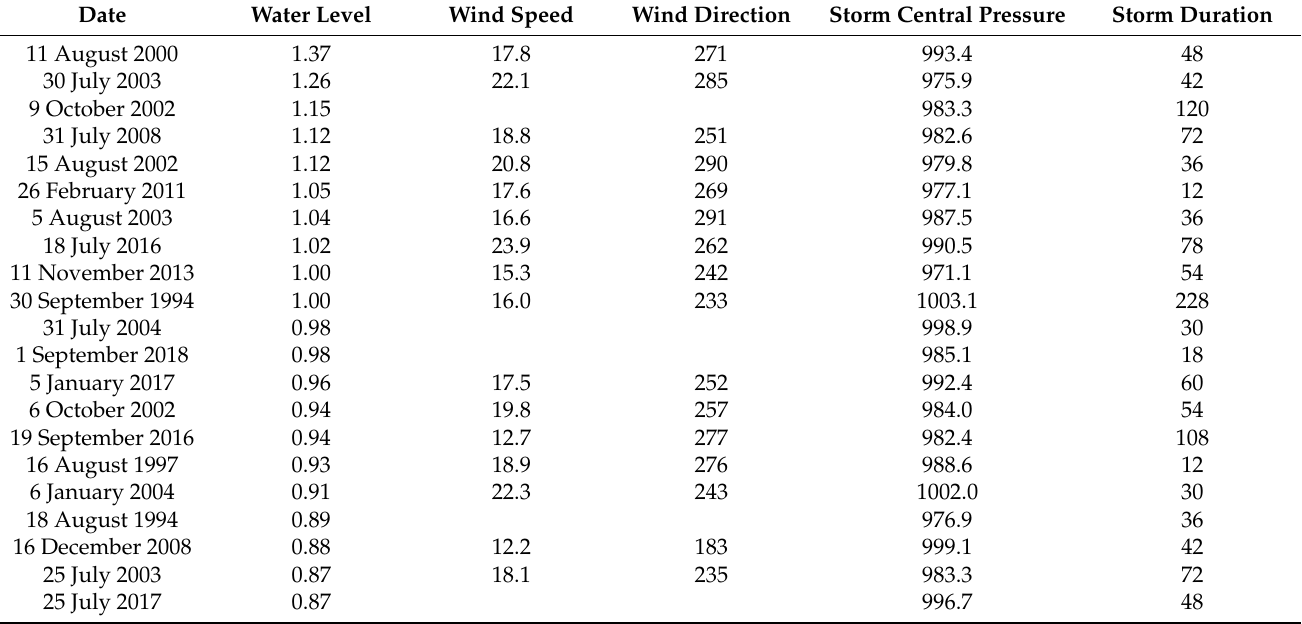
Table 1. Water level (m) extremes exceeding the daily 95th percentile with maximum daily wind speed (m/s) and mean wind direction (degrees) from the tide gauge station at Prudhoe Bay (1990– 2017). Minimum storm central pressure (hPa) and total duration of the storm (h) impacting the region identified by the storm tracking algorithm using R1 are also shown. Water levels include storm surges, astronomic tides, and seasonal water level